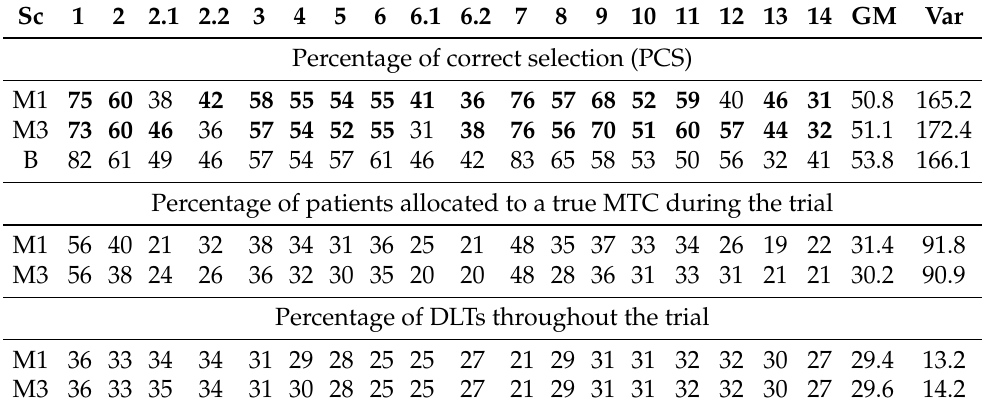
Table 7. Percentage of correct selection in comparison of 2 dose-finding designs and under the benchmark (B). Percentage of patients allocated to a true MTC during the trial and percentage of observed DLTs throughout the trial. GM is the geometric mean and Var is the variance. In the top third of the table, the highest PCS and those within less than 3% among the dose-finding designs are shown in bold for each scenario. Results are based on 4000